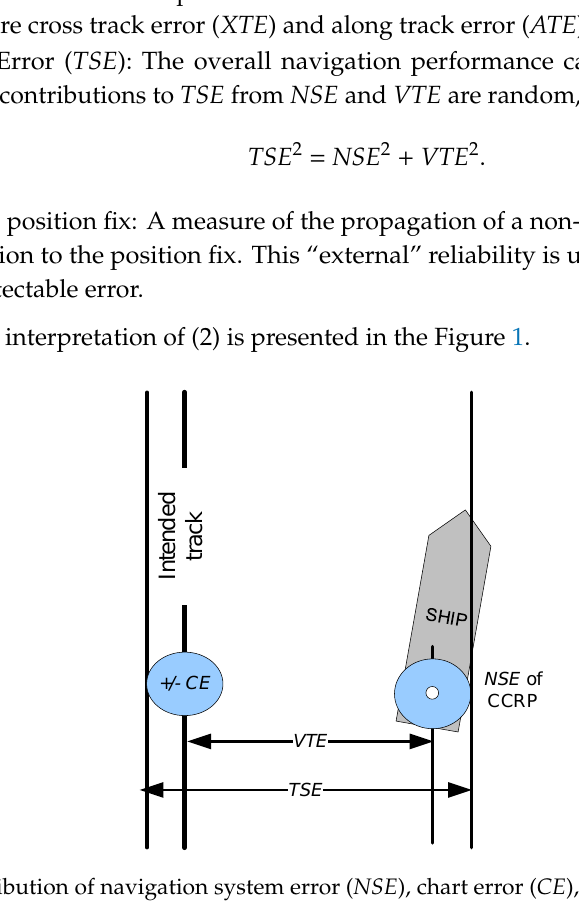
Figure 1. Contribution of navigation system error ( NSE ), chart error ( CE ), and vessel technical error ( VTE ) to total system error ( TSE ).